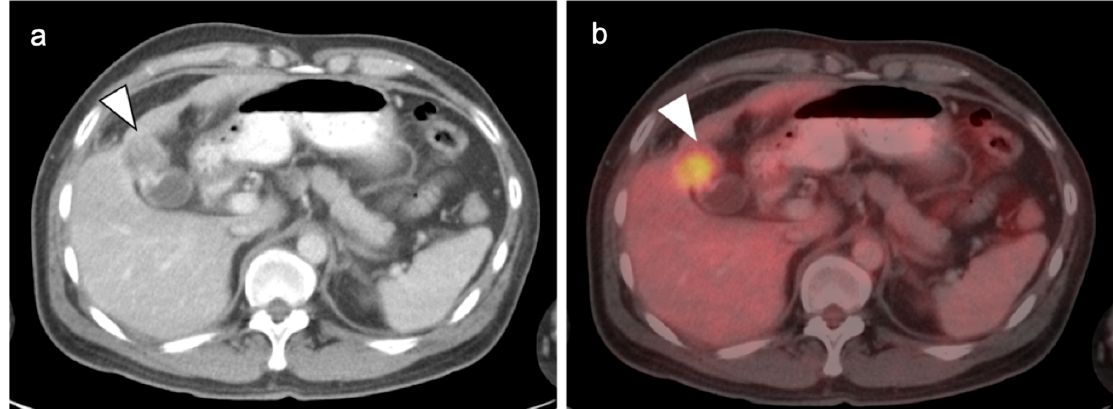
Figure 21. ( a ) Polypoid mass in the fundus of the gallbladder on axial contrast-enhanced CT was a gallbladder carcinoma at surgery (white arrowhead); ( b ) Concurrent fused axial FDG PET-CT image shows focal metabolic activity in the tumor (white arrowhead).